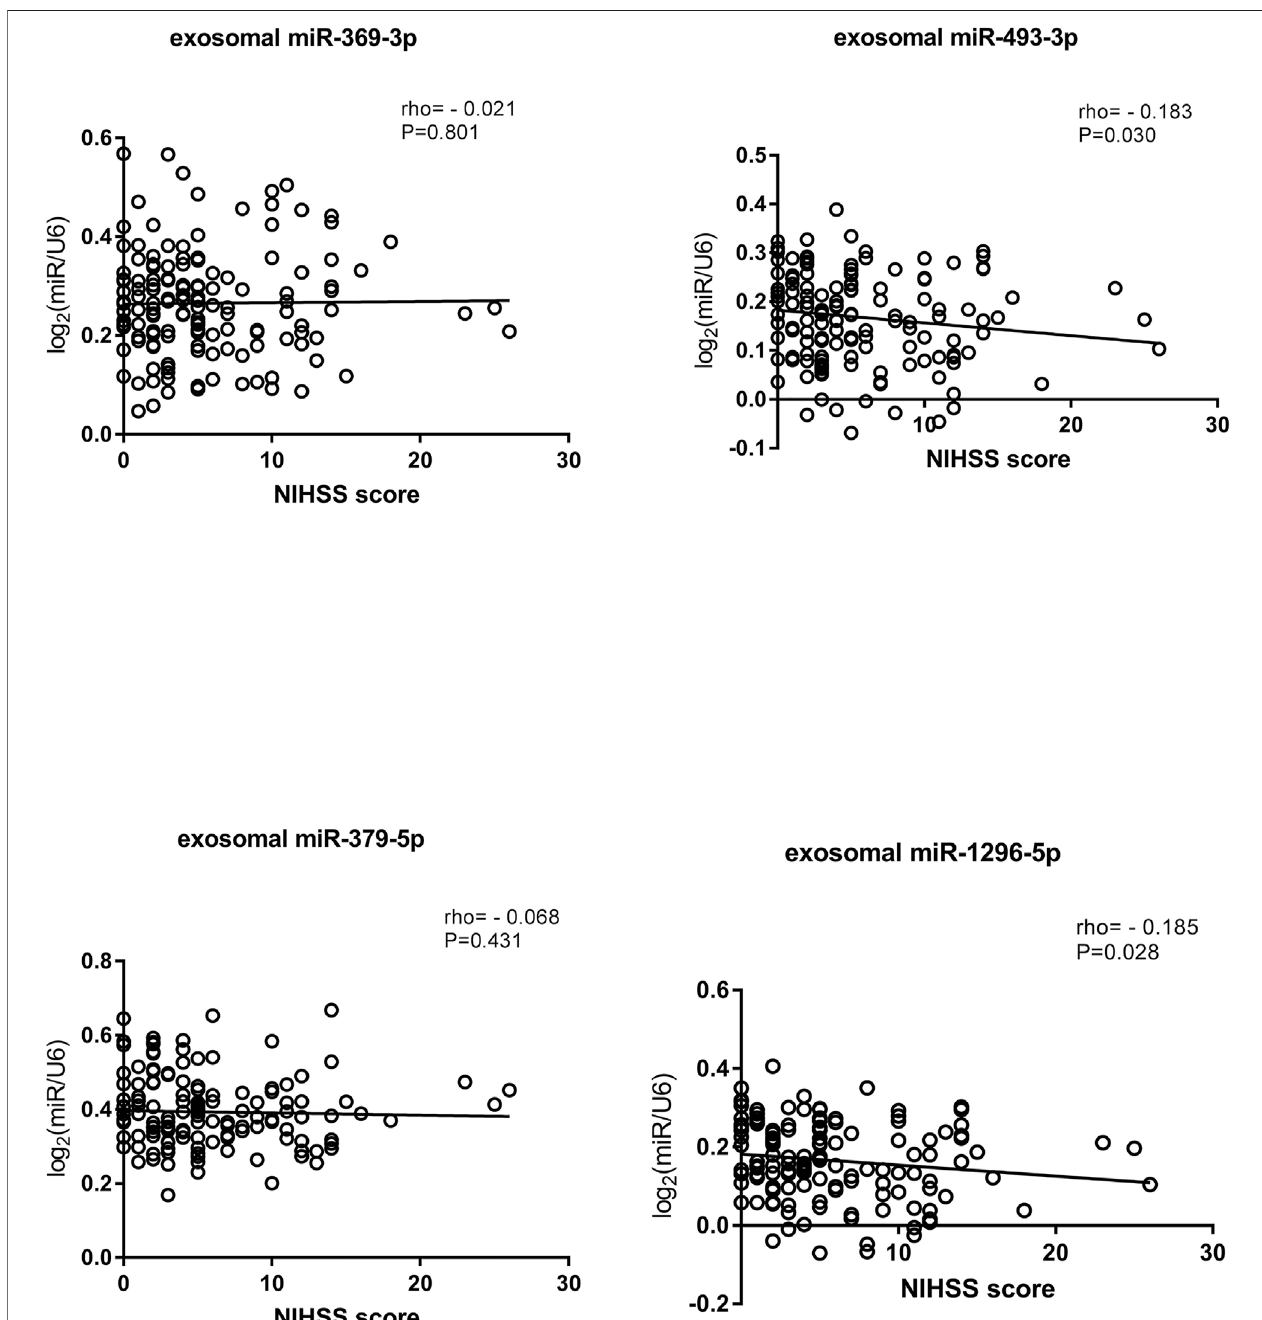
FIGURE 8 | Correlations of exosomal miRNA expression levels with NIHSS scores as determined using Spearman ’ s correlation coef fi cient (rho).